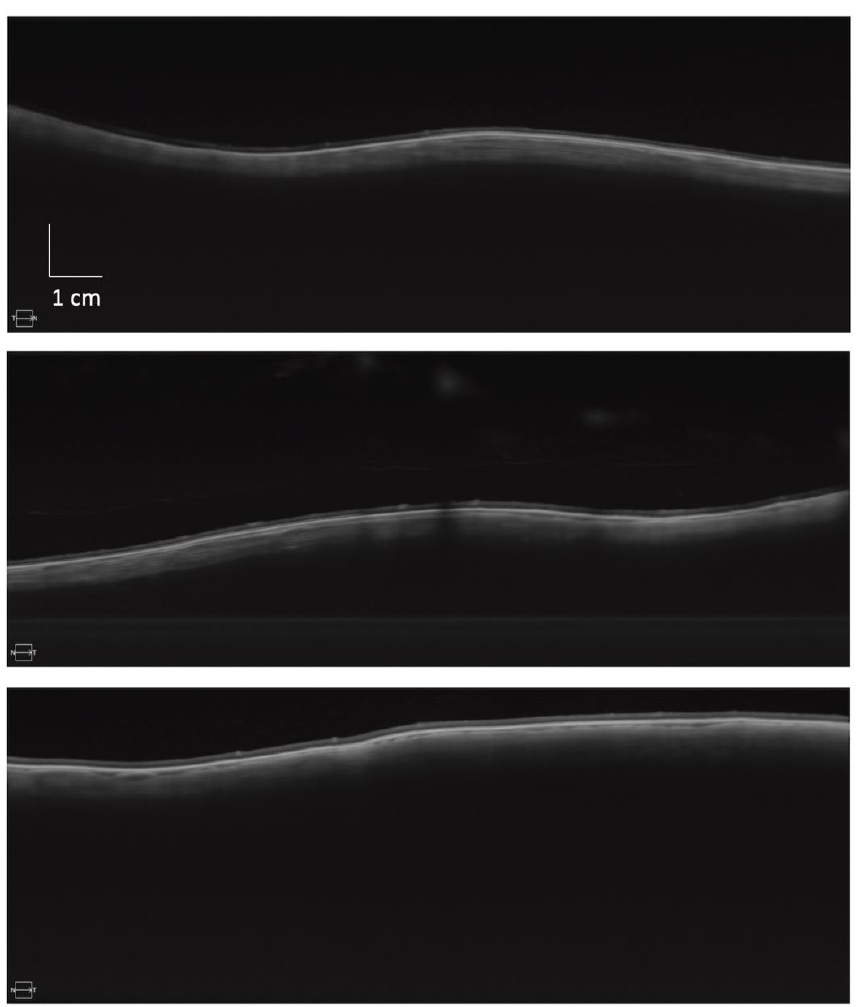
Figure 1. Sample swept-source OCT peripheral retinal images. Sample 16 × 6 mm 2 B-scan mid- peripheral retinal images from three different eyes, illustrating variation in retinal contour. Each image is composed of 100 repetitions of the same scan. 2.3. Image Processing